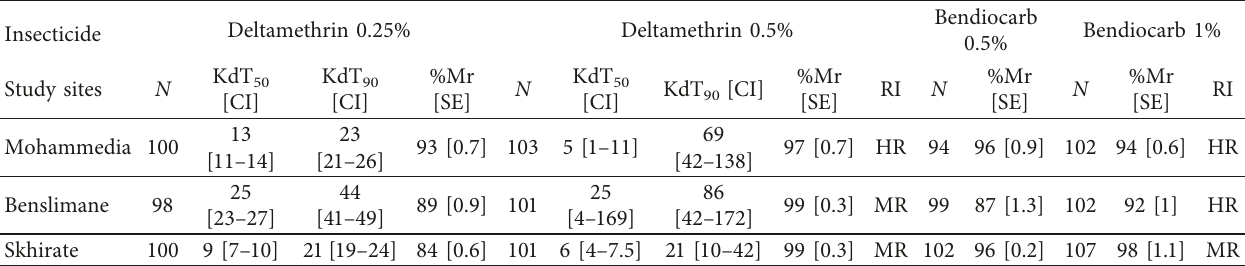
Table 2: Resistance intensity of adult Culex pipiens to deltamethrin and bendiocarb in Mohammedia, Benslimane, and Skhirate. Insecticide